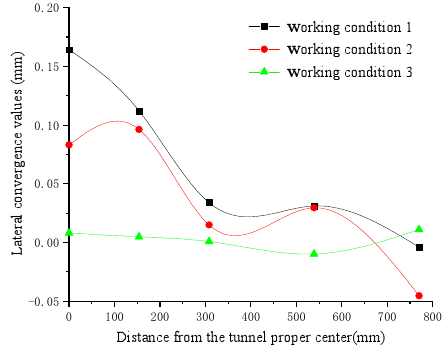
Figure 5. Change in the lateral convergence of each measurement point of the tunnel when the surcharge (172 kg) is only on the left side.